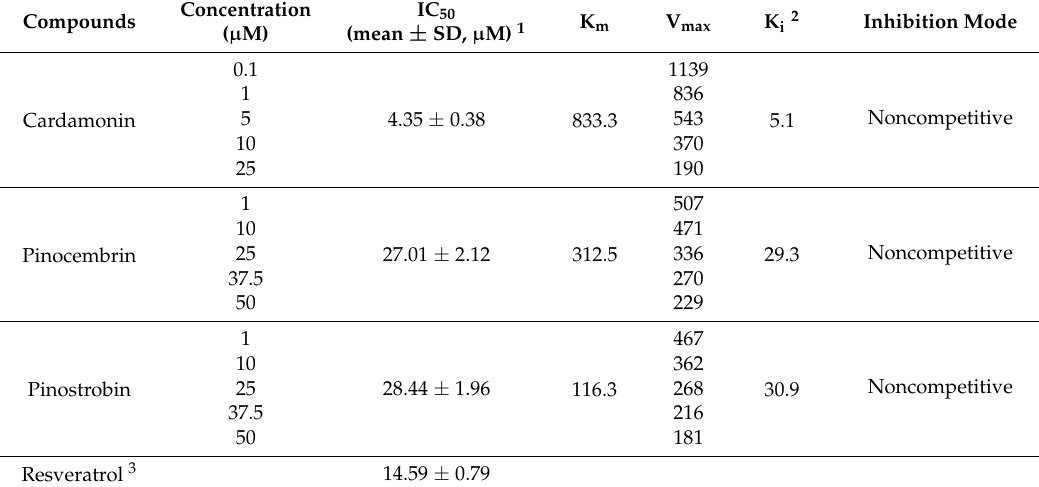
Table 1. Inhibitory activity and kinetic parameters of cardamonin, pinocembrin, and pinostrobin from B. rotunda against beta-site amyloid precursor protein cleaving enzyme1 (BACE1).